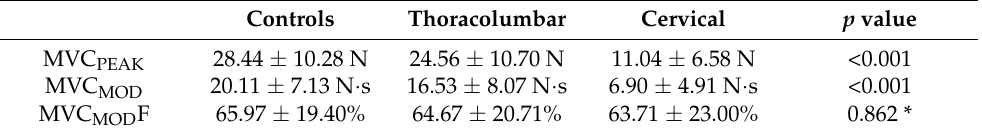
Table 2. Isometric Fatiguing Task (first 20 s) performed by control subjects and Thoracolumbar and Cervical SCI